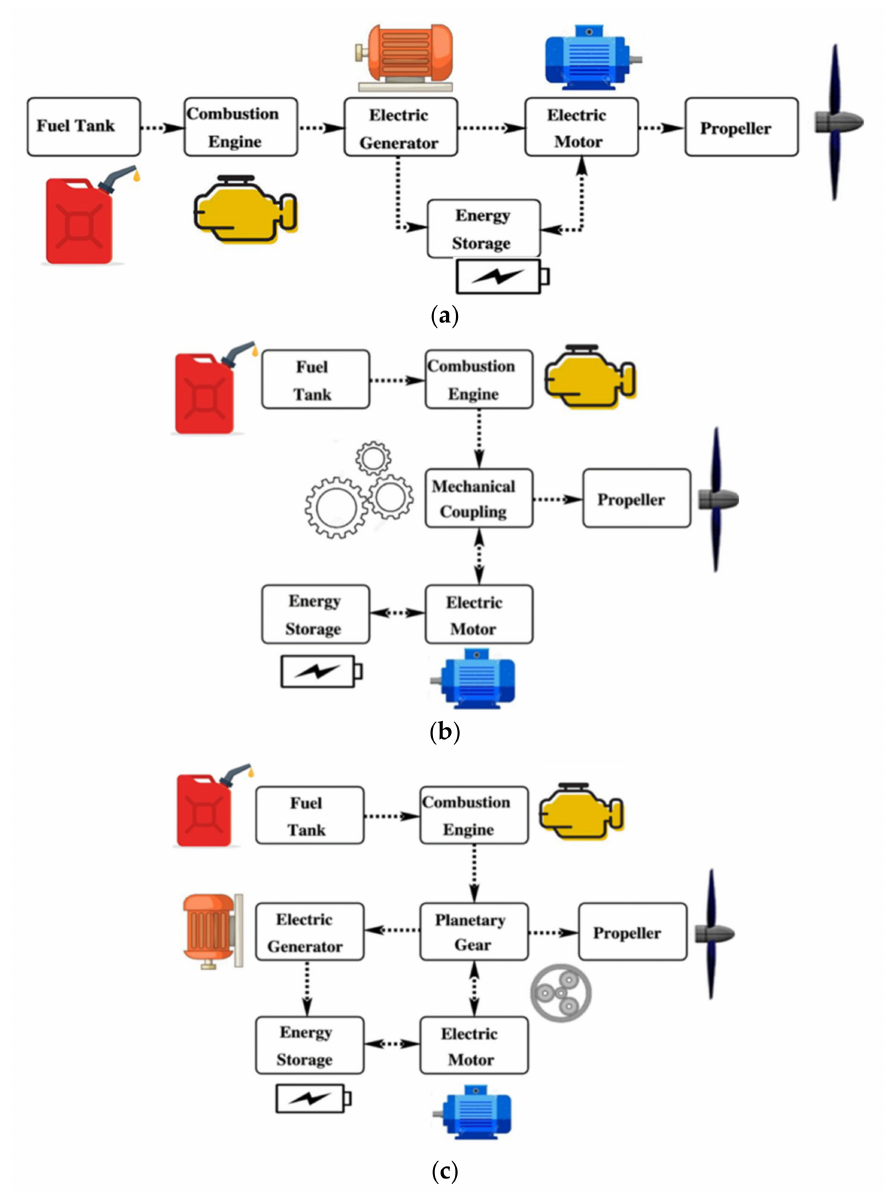
Figure 1. The possible configurations of a hybrid electric propulsion system. ( a ) series; ( b ) parallel; ( c ) series–parallel